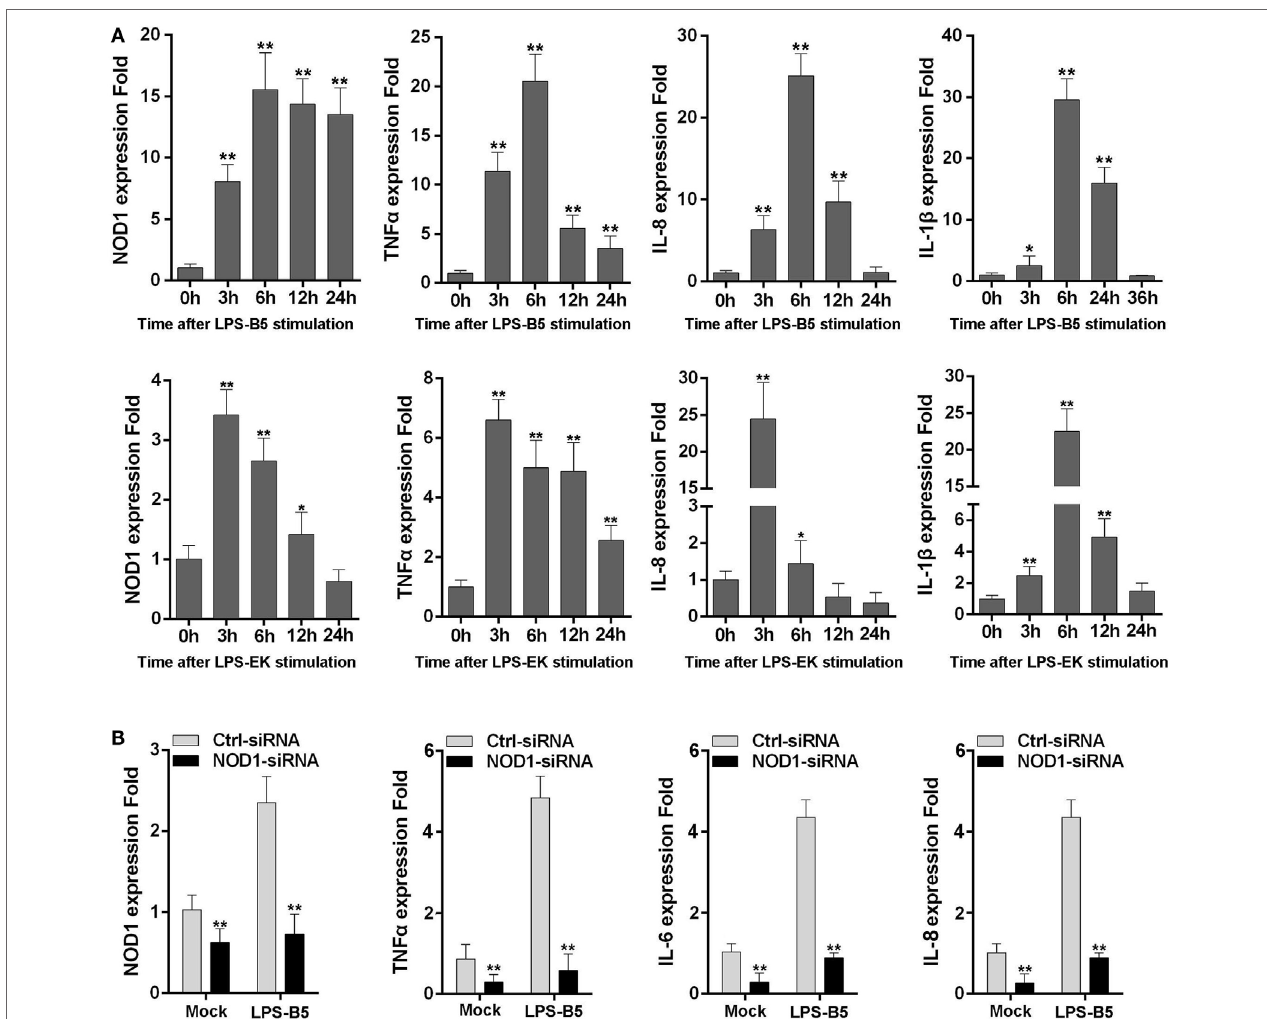
FigUre 3 | NOD1 can respond to lipopolysaccharide (LPS). (a) The time-course expression profiles of NOD1, TNF α , IL-8, and IL-1 β in LPS-treated miiuy croaker macrophages. (B) Transfect the NOD1-siRNA3 into miiuy croaker macrophages, and then stimulate the macrophages by using LPS-B5, and after treating for 6 h, detect the expression of NOD1, TNF α , IL-6, and IL-8 at transcript levels in LPS-treated or untreated macrophages. The expression of β -actin was used as the internal control, and the cells transfected with negative control siRNA were used as the mock control; the data were indicated as mean ± SE. The statistically significant differences between control and experience groups are indicated with asterisks (* P < 0.05 and ** P <